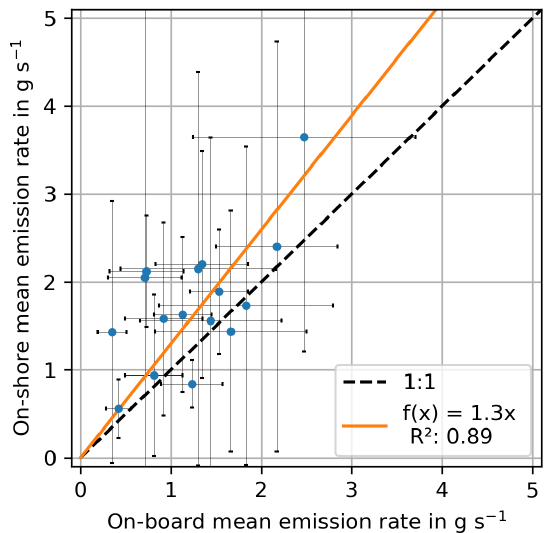
Figure 9. Scatterplot of on-board and onshore emission rates. Each dot represents the mean value for one ship, and error bars indicate respective standard deviations. For ships with more than one main engine, the number of engines has been taken into account for the on-board emission rates (also see Table